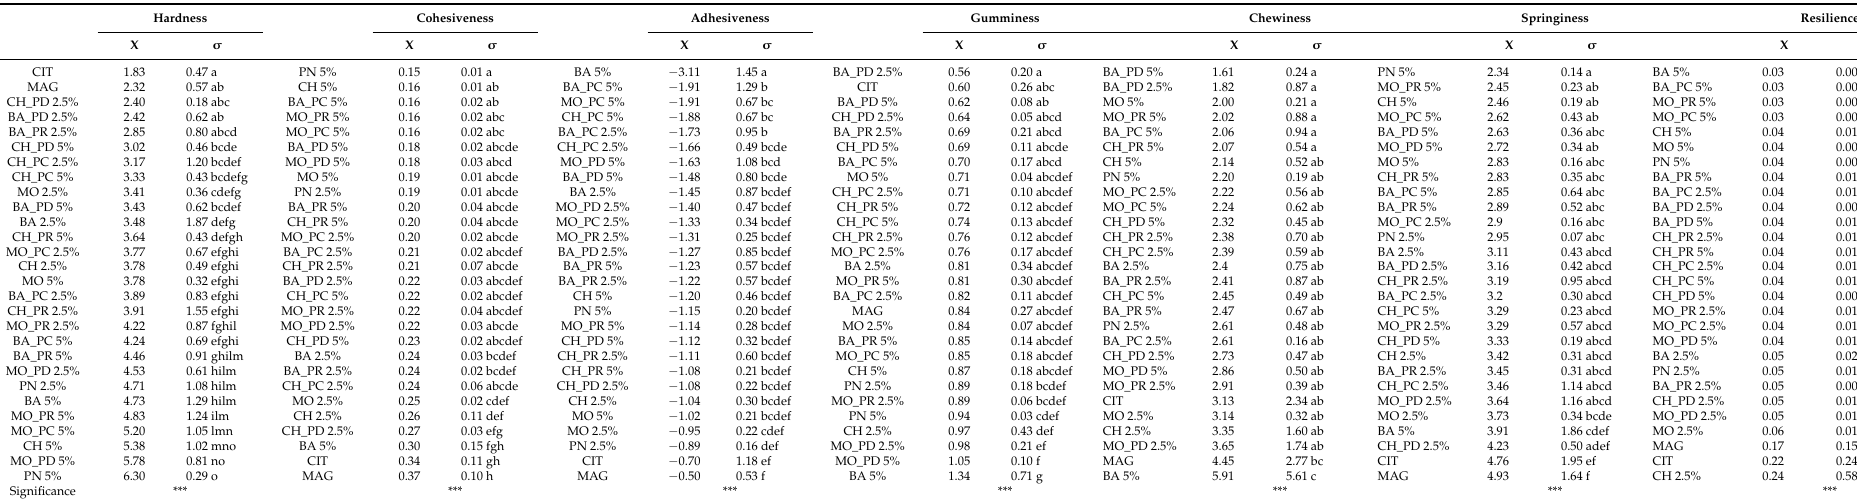
Table 4. Results of the texture analysis (X—mean; σ —standard deviation) for the tofu samples obtained with the traditional and innovative coagulants at two concentrations (2.5% and 5%) and results of variance analysis with post hoc Duncan’s test (BA—Barbera; CH—Chardonnay; PN—Pinot Noir; MO—Moscato; MAG—magnesium chloride; CIT—citric